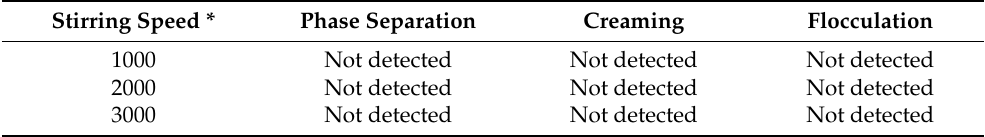
Table 12. Kinetic stability of